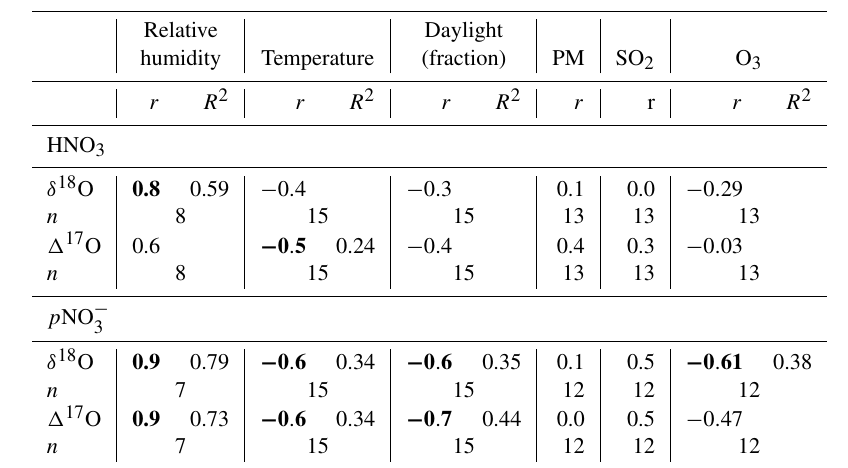
Table 6. Correlation coefficients ( r ) of NO − isotopic deltas with meteorological parameters and concentration (or ratio) of co-contaminants. 3 In bold are the significant correlation coefficients, equal or above the 95% significance value.